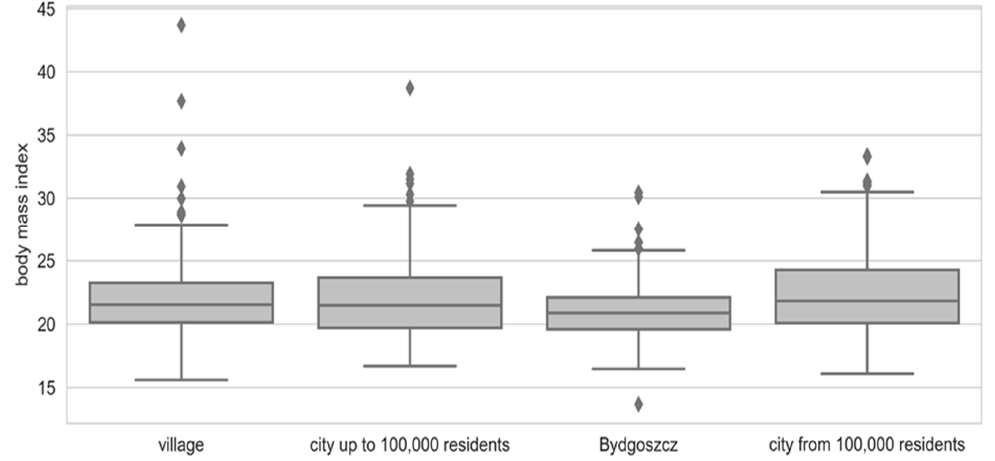
Figure 1. Graphical characteristics of the BMI of the surveyed women differing in the size of the place of residence. The chart shows: minimum, first quartile, median, third quartile, maximum, extreme observations and atypical observations. ⬪ —extreme observations and atypical observations. The demographic characteristics of the observation’s participants are presented in Table